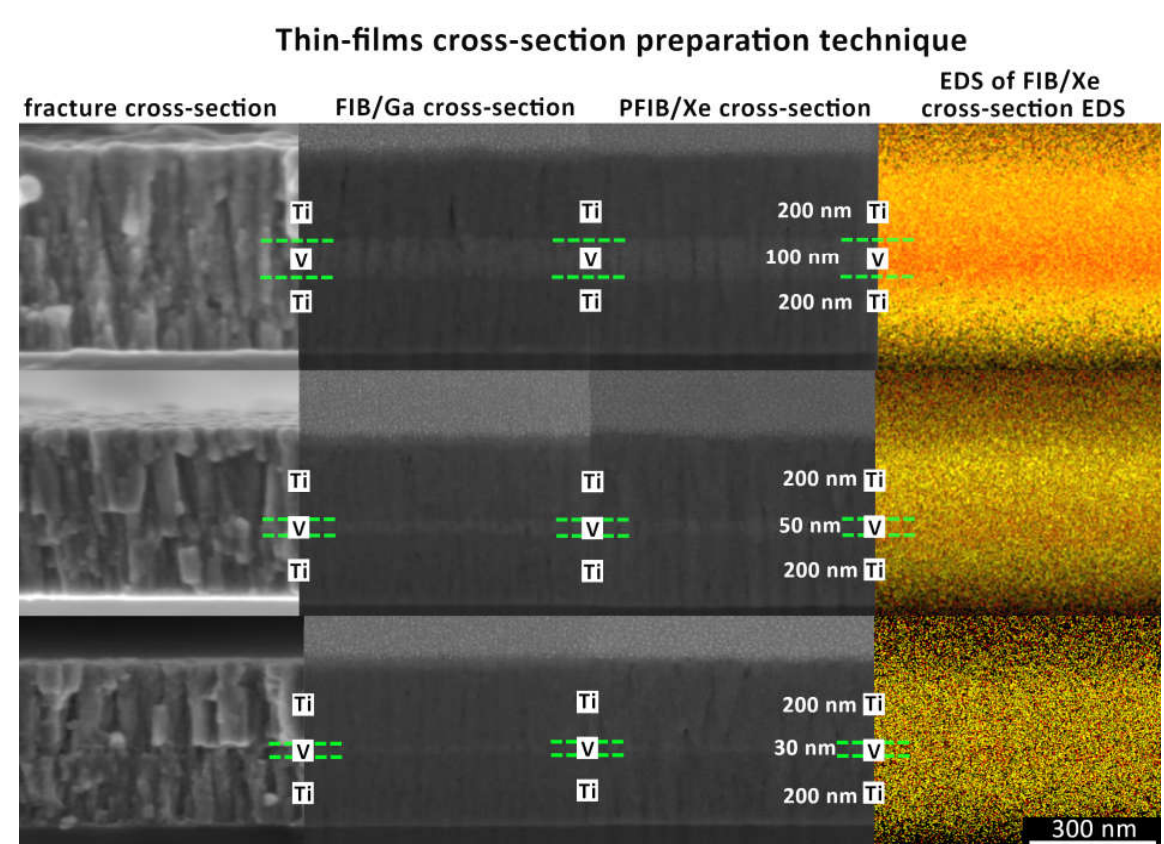
Figure 2. Cross sections of Ti/V/Ti multilayers with various thicknesses of middle V layer (100, 30, and 10 nm) based on SEM and EDS measurements, prepared by fracture technique, FIB/Ga, and PFIB/Xe. Note: The SEM images were recorded at high resolution and their original version can be found in the Supplementary Materials.